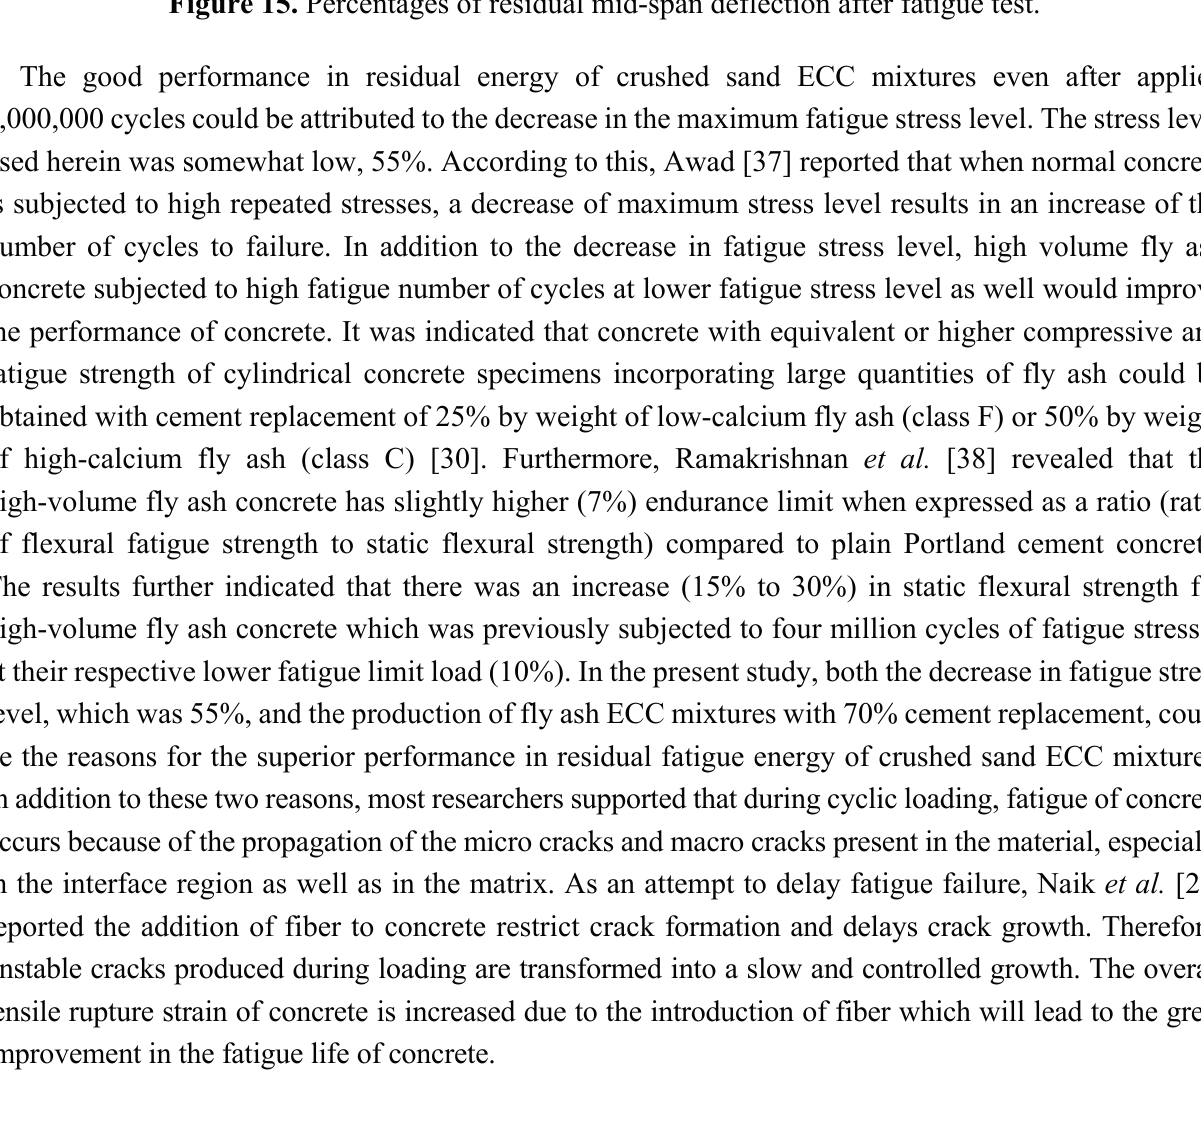
Figure 15. Percentages of residual mid-span deflection after fatigue